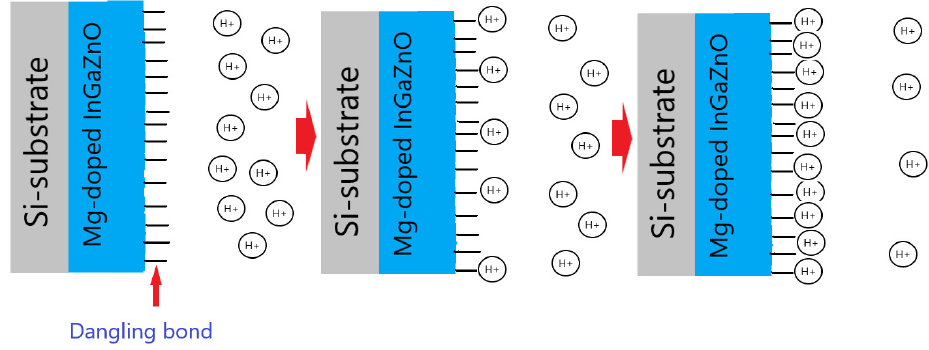
Figure 7. The mechansim for hysteresis and drift voltage shifts caused by dangling bonds. Based on previous reports [23,35–37], Mg doping can generate Mg 2+ near the surface of the membrane and attract some OH − ions in the electrolyte solution. Therefore, the OH − in the diffusion layer of the electrolyte solution might decrease, and therefore the C DL (diffusion capacitance) might decrease as well. The illustration of C DL decrease is shown in Figure 8. Then, the membrane parameter β , the surface potential, and overall sensitivity could also be boosted. However, though NH 3 plasma treatment could incorporate N atoms into the membrane and potentially decrease defects, it could not cause Mg atoms in the membrane to be uniformly distributed in the same way that Rapid Thermal Anneaing (RTA) annealing did in our previous research. Therefore, linearity could be decreased due to the uneven distribution of Mg atoms with the plasma treatment. In the future, a combination of RTA annealing and NH 3 plasma treatment could be conducted to further improve the sensitivity and linearity of the membrane. As the plasma treatment time increased to 6 min, the hysteresis voltage and drift rate increased drastically. Since plasma treatment could damage the film by etching away the surface, plasma treatment with a time longer than 6 min could deteriorate the surface material quality consistent with the XRD analysis as shown in Figure 5. Therefore, plasma treatment with an appropriate time could optimize the material properties and device performance.